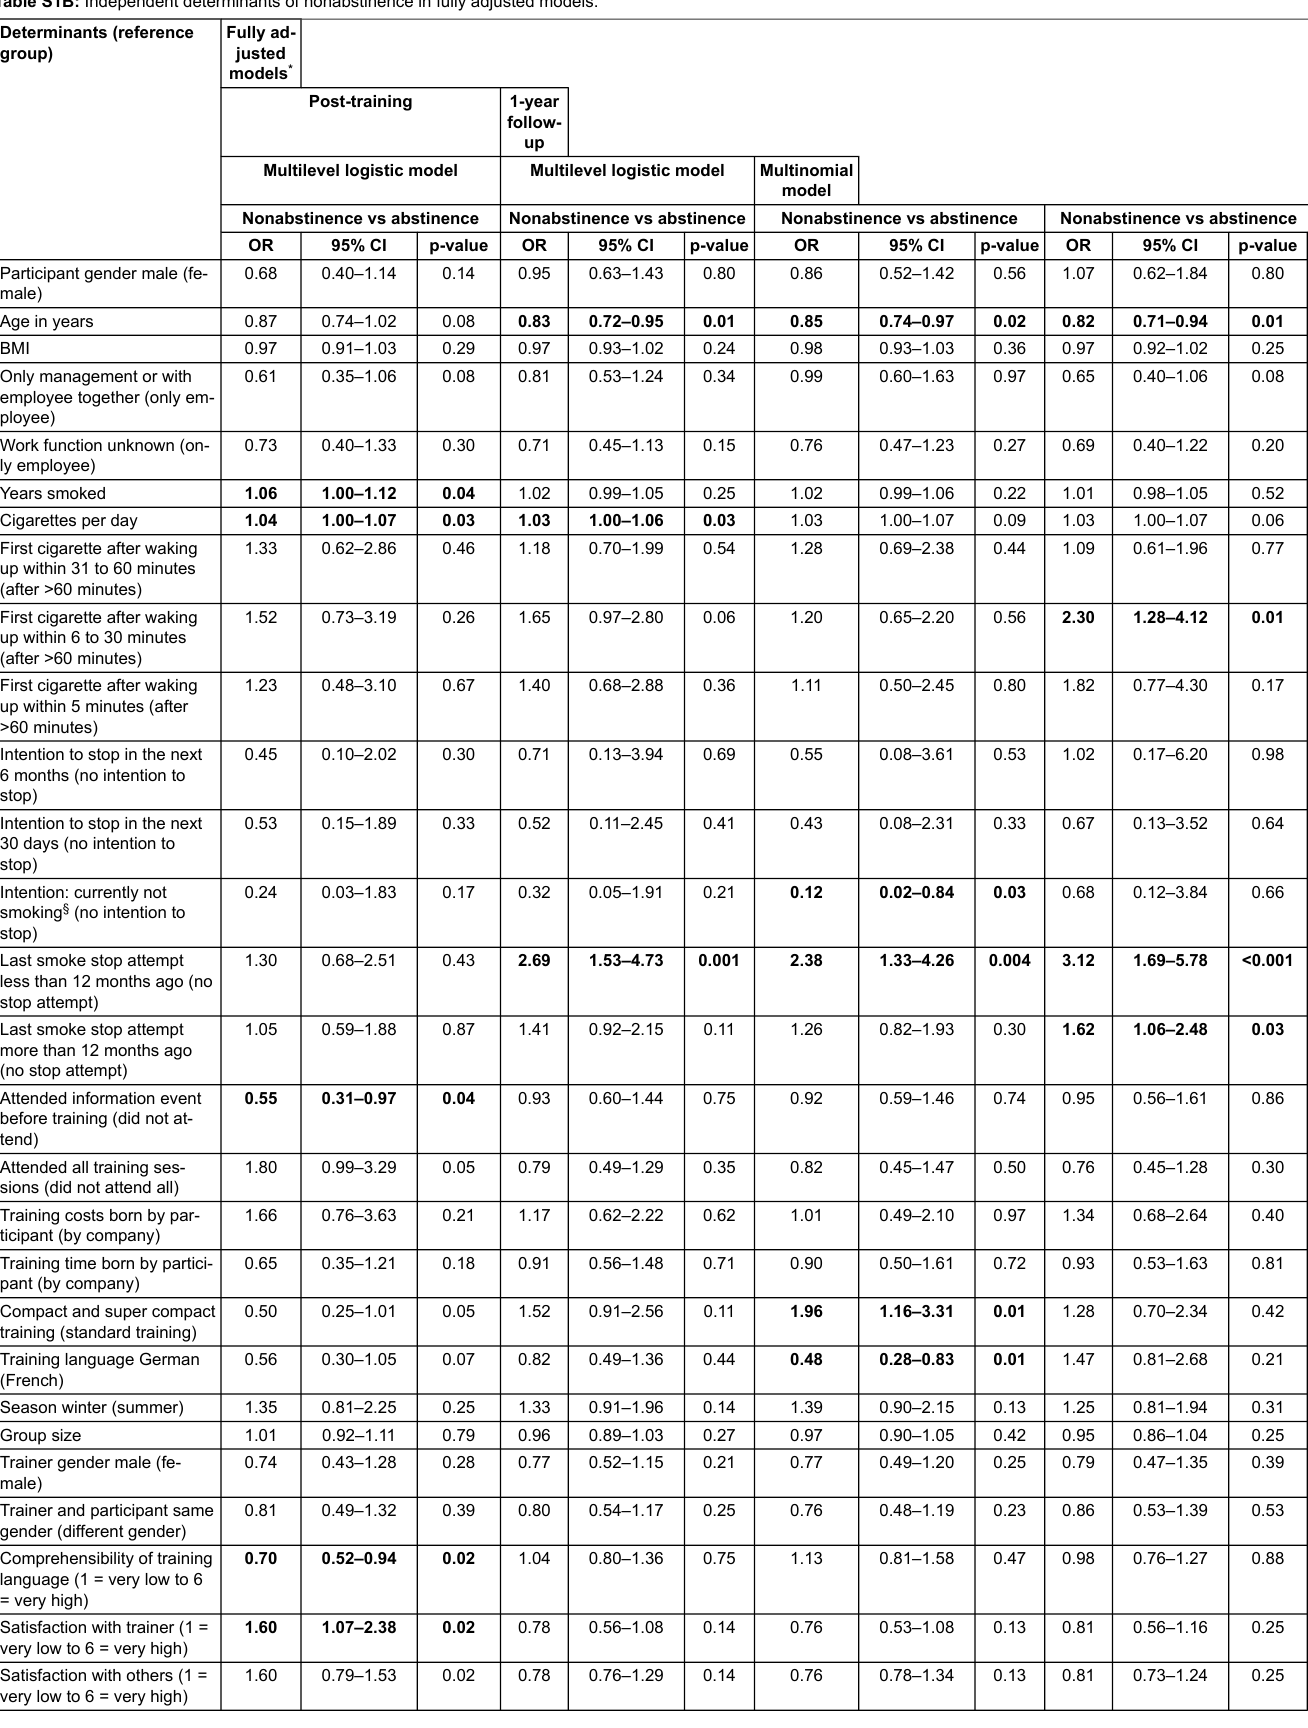
Table S1B: Independent determinants of nonabstinence in fully adjusted